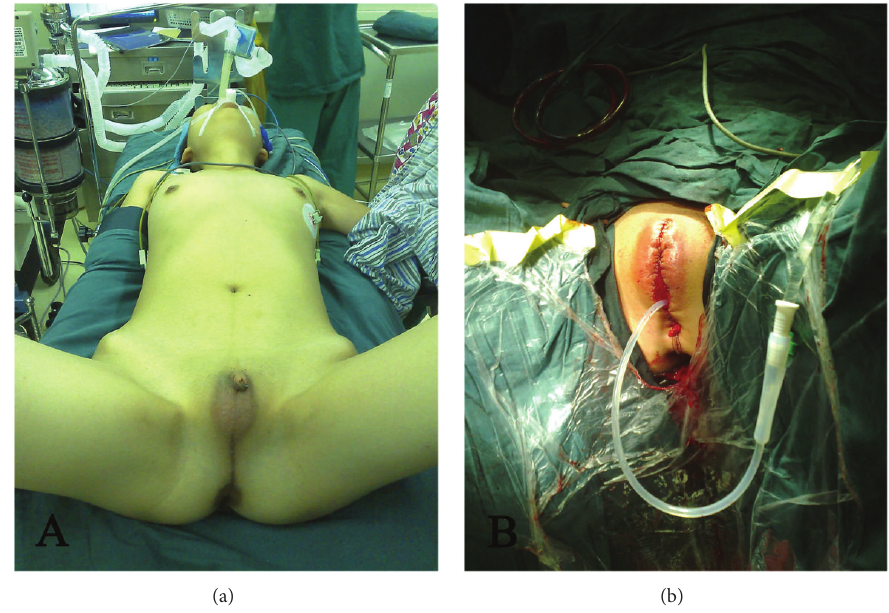
Figure 1: Externalia plasty for ovotesticular DSD. (a) Before surgery. The vagina was not obvious, and the vagina and urethra shared an outlet at the top of small penis with poor development. (b) After surgery. The outlet of the vagina and urethra was exposed, and the vagina and urethra were separated. The urethra was extended for urination control and vagina exposure. Patients agreed with publication of these